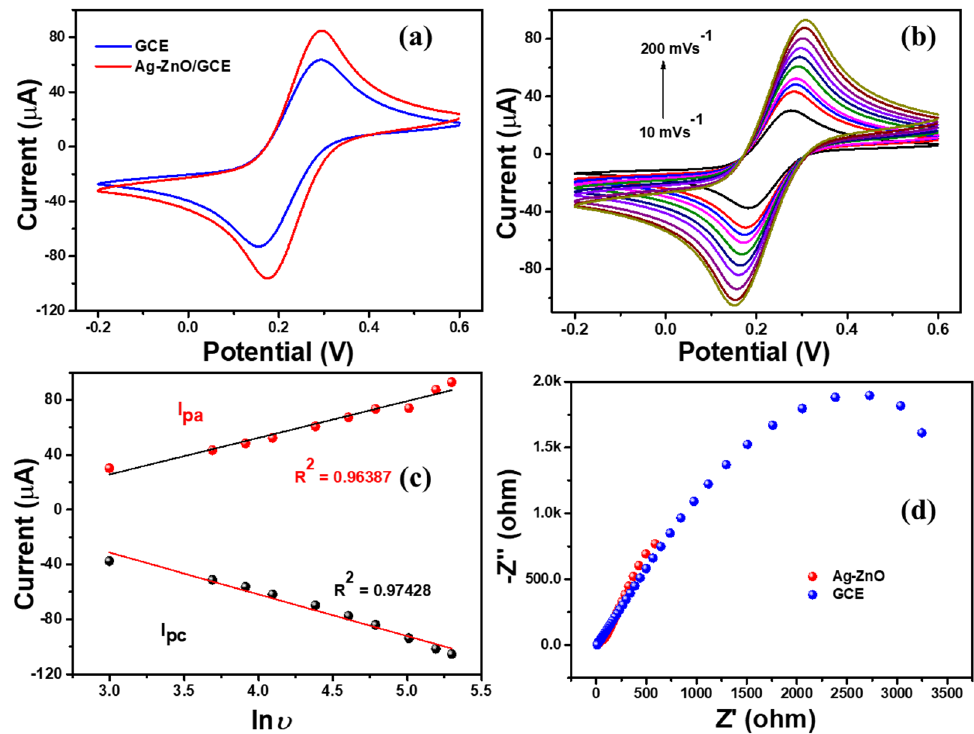
Figure 6. ( a ) CV responses of bare GCE and Ag-ZnO/GCE, ( b ) scan rate variation of Ag-ZnO/GCE, ( c ) linear regression plot ( d ) Nyquist plot for bare GCE and Ag-ZnO/GCE electrode with 5 mM K 3 [Fe(CN) 6 ] in 0.1 M KCl electrolyte.